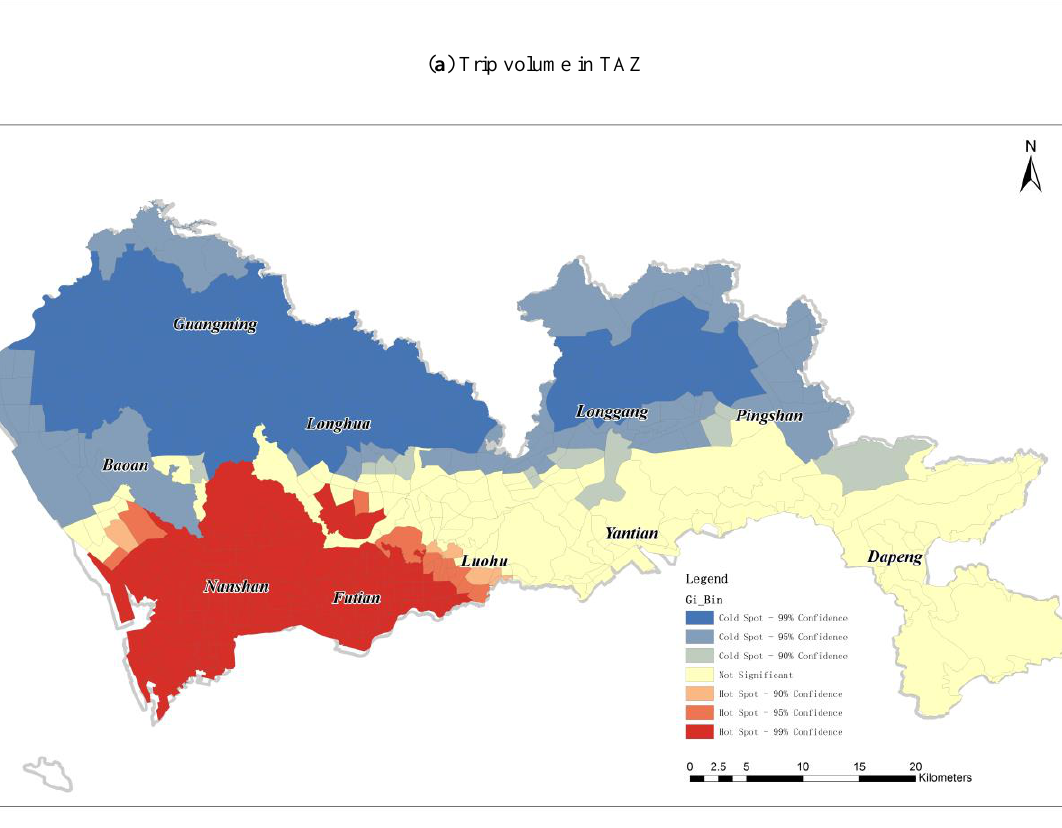
( b ) Spatial dependence characteristics in TAZ Figure 5. ( a , b ) Spatial distribution characteristics of trip origins at TAZ